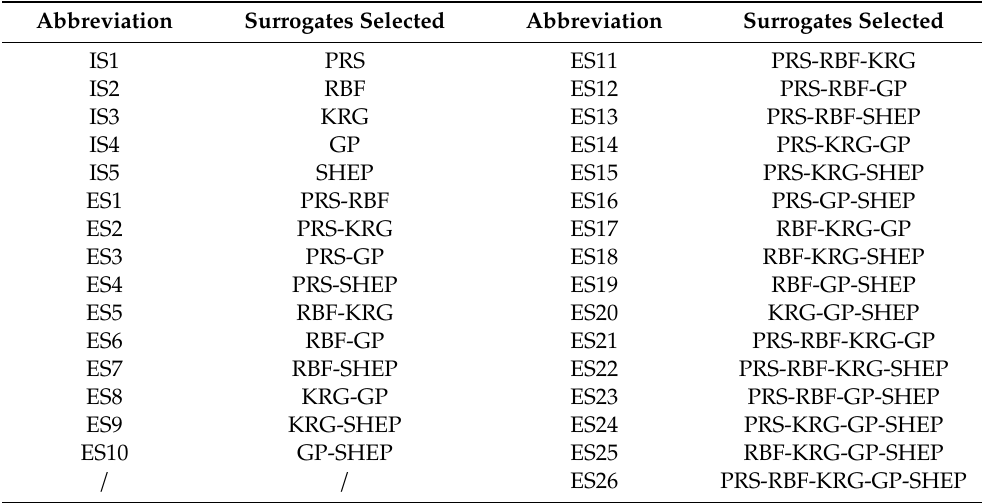
Table 1. Information on the selected individual surrogates and forming ensemble